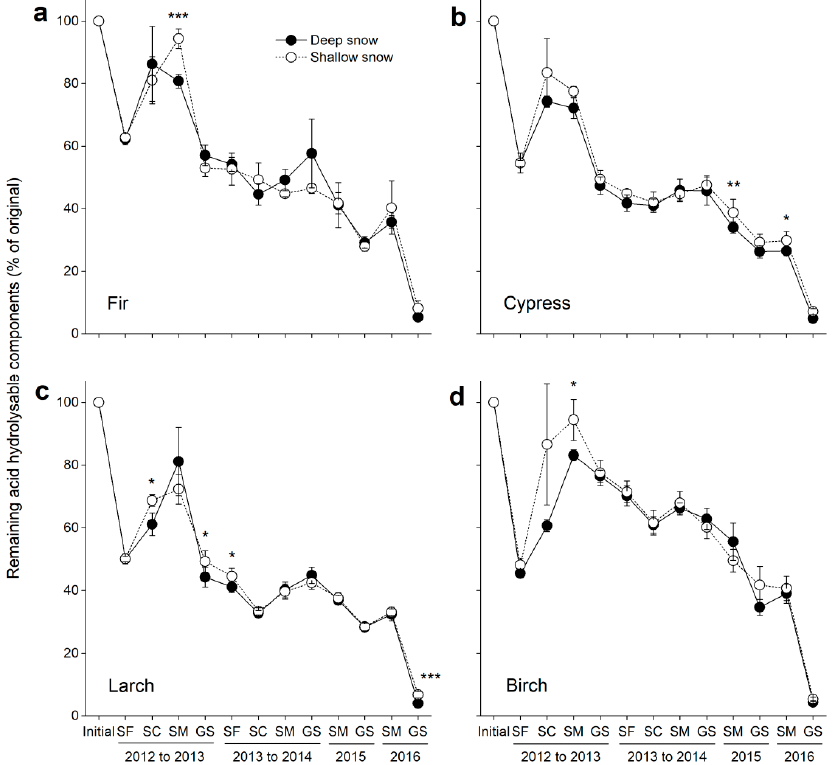
Figure 6. Remaining acid hydrolysable components (±SE, n = 6) in decomposing litter in the deep and shallow snow plots. ( a ) Fir, ( b ) cypress, ( c ) larch, and ( d ) birch. SF: snow formation stage, SC: snow coverage stage, SM: snowmelt stage, and GS: growing season. * p < 0.05, ** p < 0.01 and *** p < 0.001.